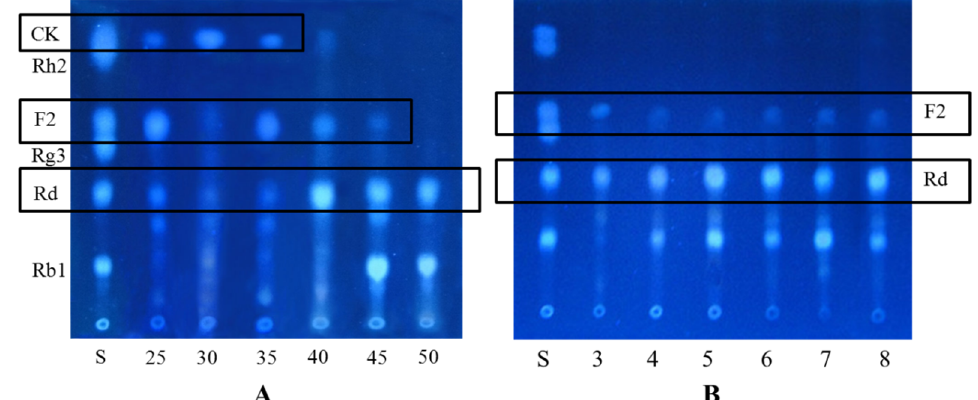
Figure 6. Influences of different temperature and reaction pH values on the biotransformation of Rb1. ( A ) Temperature (°C); ( B )